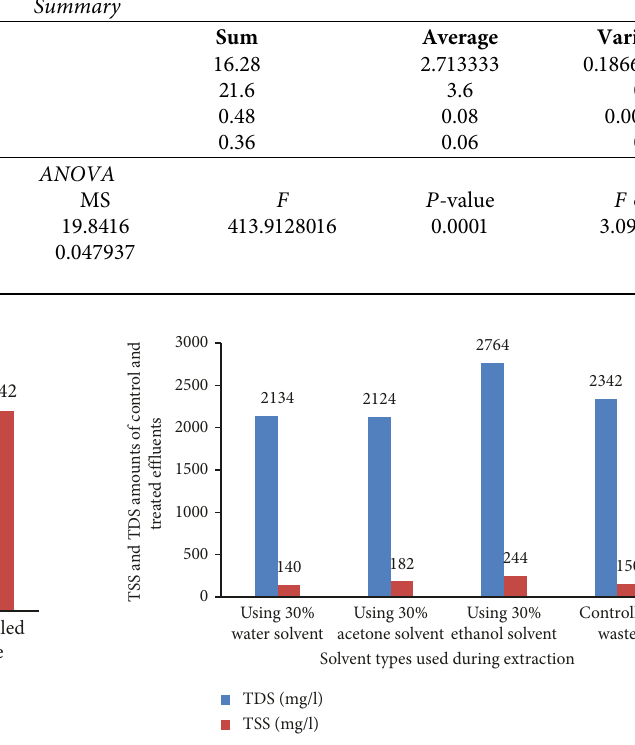
Figure 7: TDS and TSS values of controlled and treated wastes by using leaf 30% materials extracted by different extraction solvents.